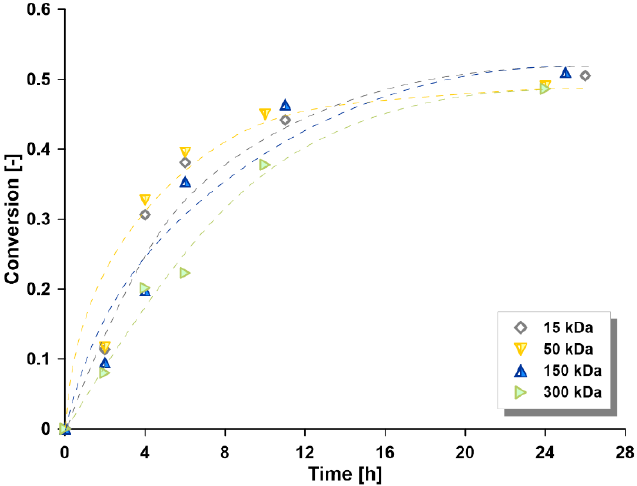
Figure 9. Comparison of conversion level for all of the investigated membranes. Table 3. Results of determination of lipase activity in enzyme membranes depending on membrane cut-off.